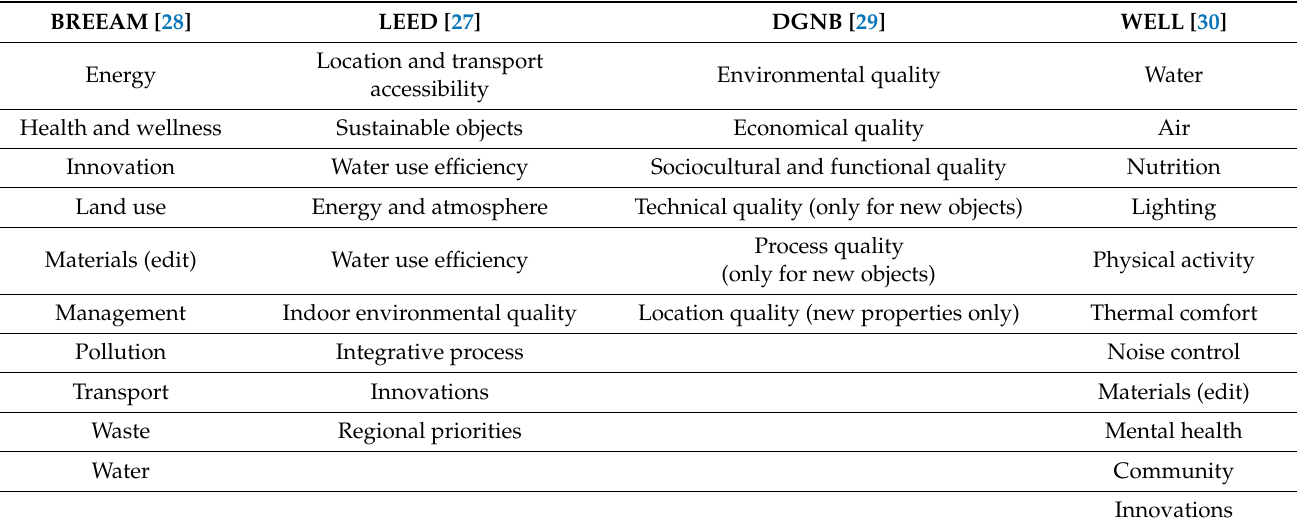
Table 3. Sections of the assessment of buildings according to international “green” standards.